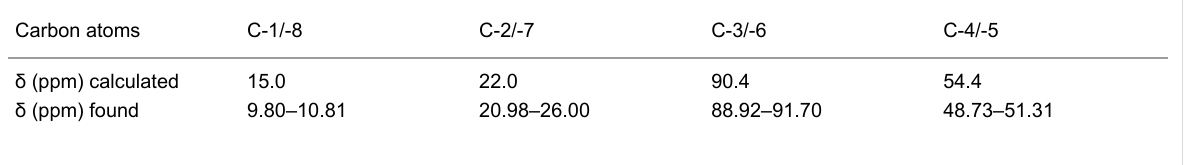
Table 7: Calculated and experimental 13 C shifts for 18 .